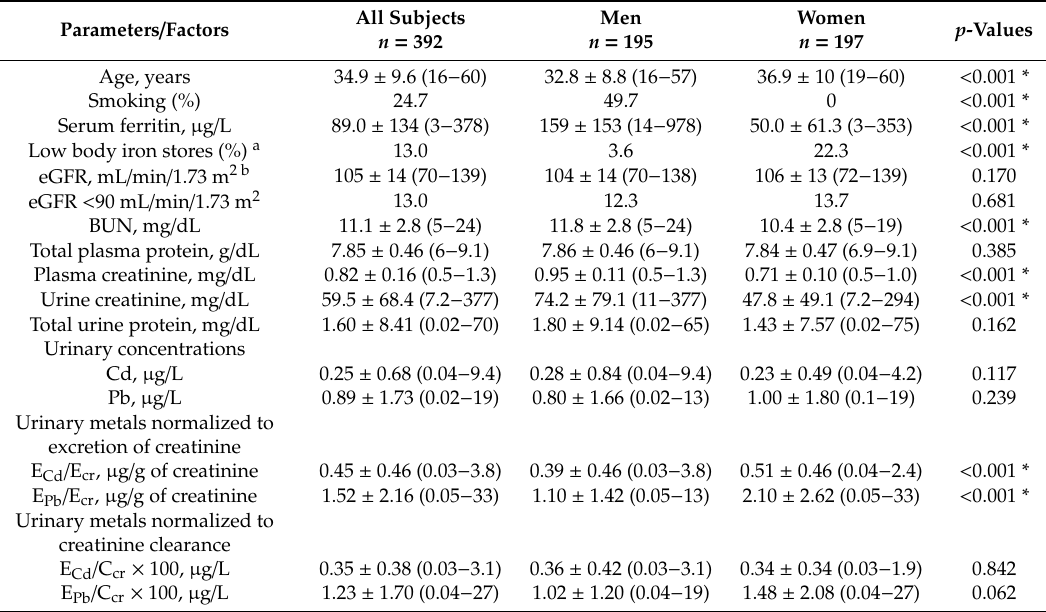
Table 1. Descriptive characteristics of study